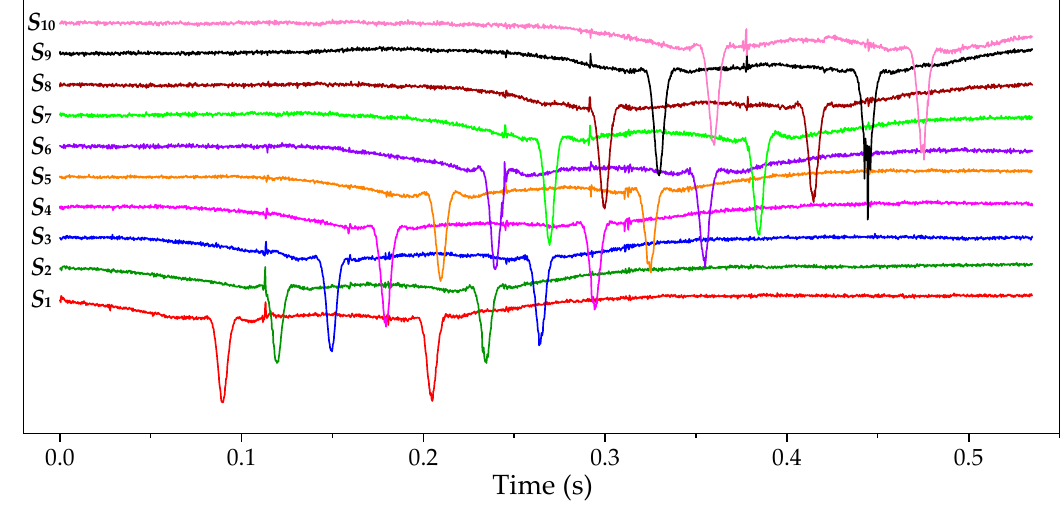
Figure 21. Raw outputs of sensors during the passage of wheelset under actual service state.